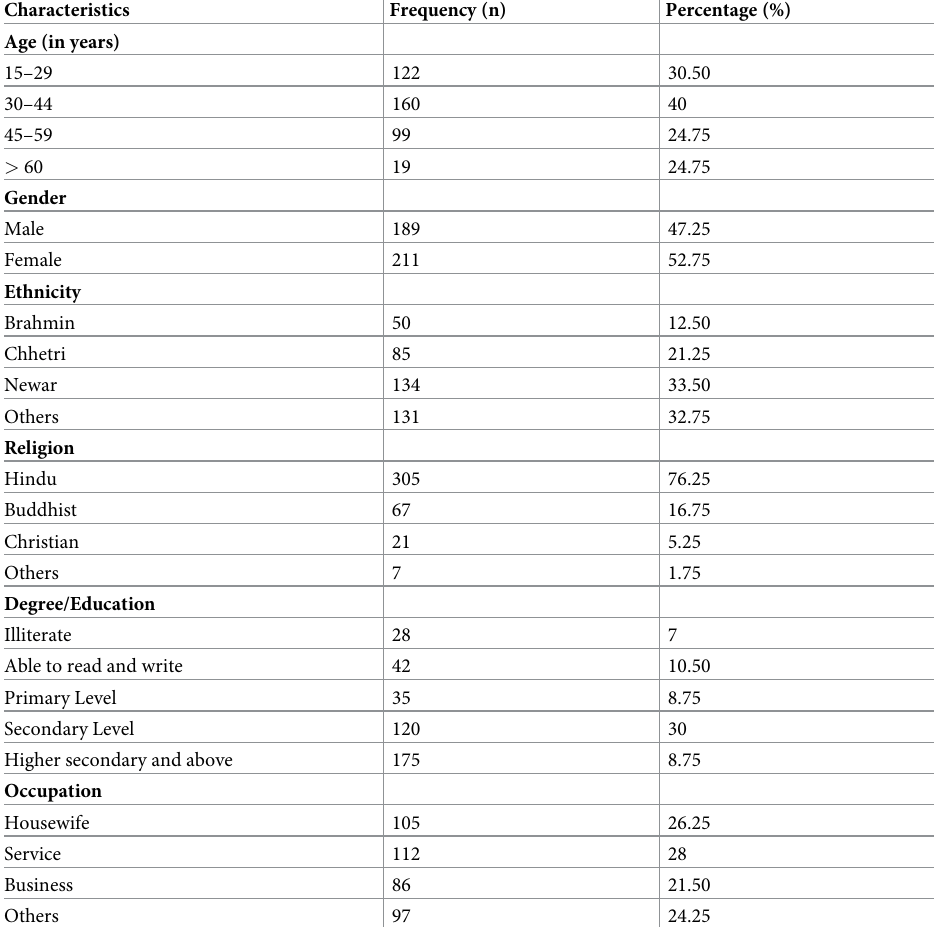
Table 1. Socio-demographic characteristics of the respondents (N =